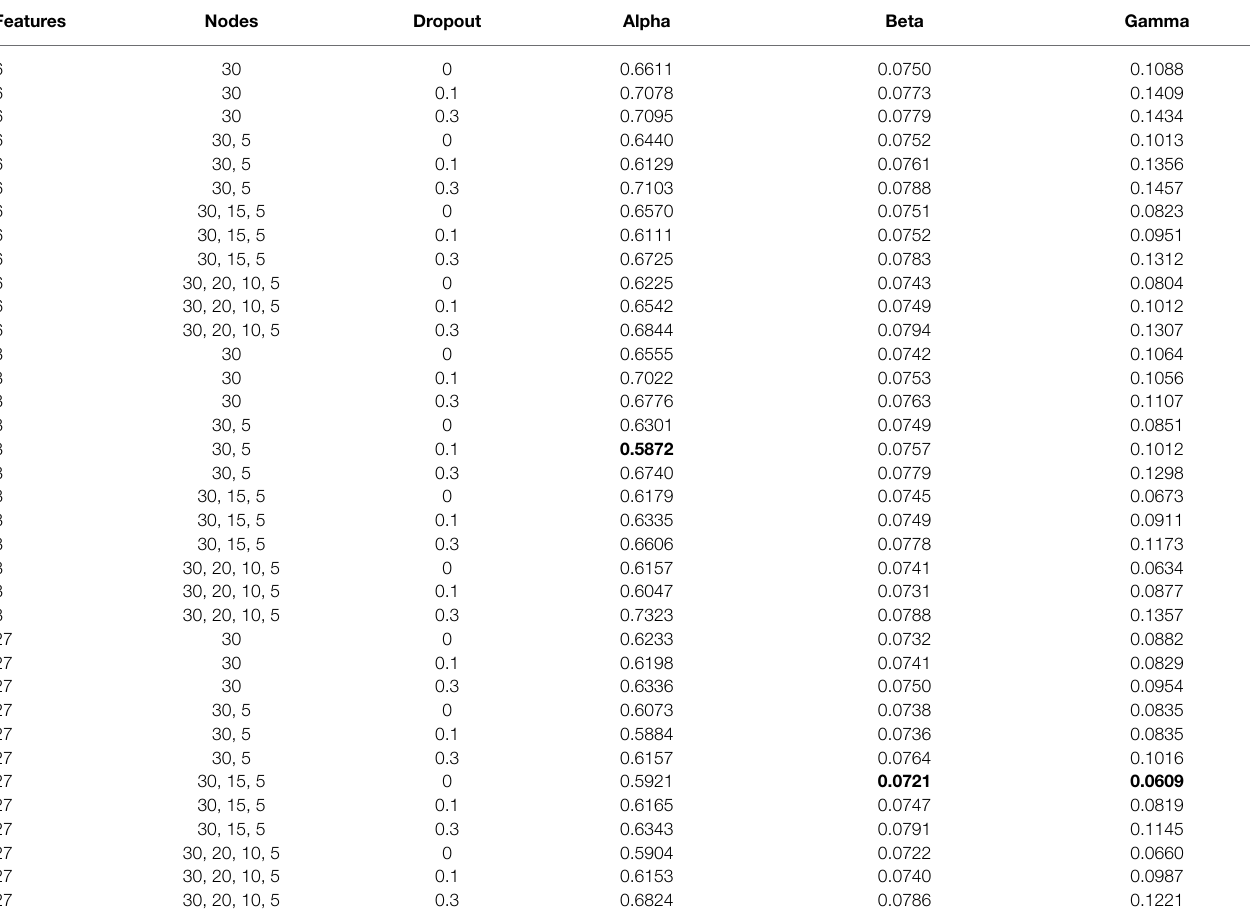
TABLE 2 | Prediction accuracy for test set of all tested